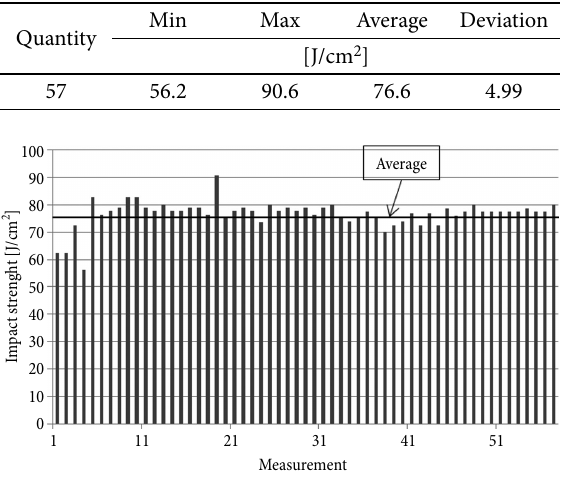
Fig. 10. A dispersion of the measurement of impact strength values of aluminium connecting rods